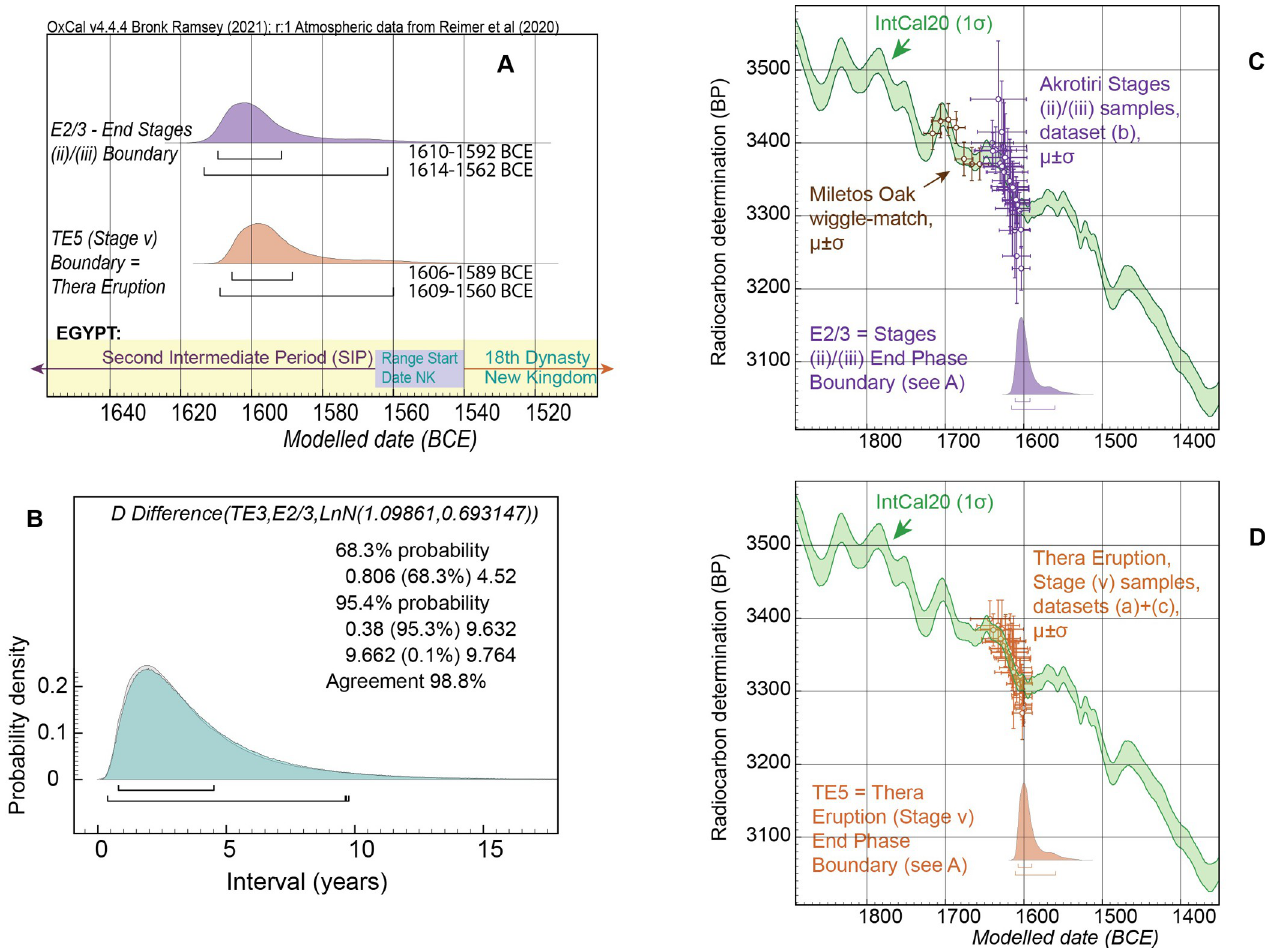
Fig 9. Dating of Akrotiri stages (ii)/(iii) and the Thera eruption (stage v) from Model 1. (A) Results for the end of Stages (ii)/(iii) Boundary and the Thera Eruption Boundary from Model 1 run 3 with log-normal, LnN(ln(3),ln(2)), constraint applied (Table 1), detailing the 68.3% and 95.4% hpd calendar age ranges. Comparison is also shown versus the approximate start date of the NK = 18 th Dynasty in Egypt ~1565/1540 BCE [7–9, 25, 30, 44, 61–63]. (B) Modelled posterior (solid, cyan) probability versus the log-normal prior (hollow distribution) for the Difference constraint. As indicated by the OxCal Agreement value of 98.8%, there is a very good correspondence between modelled result and prior assumption (see also S1 Fig). (C) Fit of Miletos wiggle-match and modelled dataset (b) (stages ii/iii) individual data against IntCal20 curve (1 σ ages and μ±σ modelled calendar ranges) before end of Phase Boundary (see A) from Model 1. (Note: the Miletos wiggle-match oak data are shown placed against IntCal20 in Fig 9C, where they are more easily viewed, versus in Fig 9D, although they used as relevant to the non-Thera dataset (a) samples included in Fig 9D). (D) Fit of modelled datasets (a)+(c) (Thera eruption, stage v) individual data against IntCal20 curve (1 σ ages and μ±σ modelled calendar ranges) before end of Phase Boundary (see A) from Model 1.